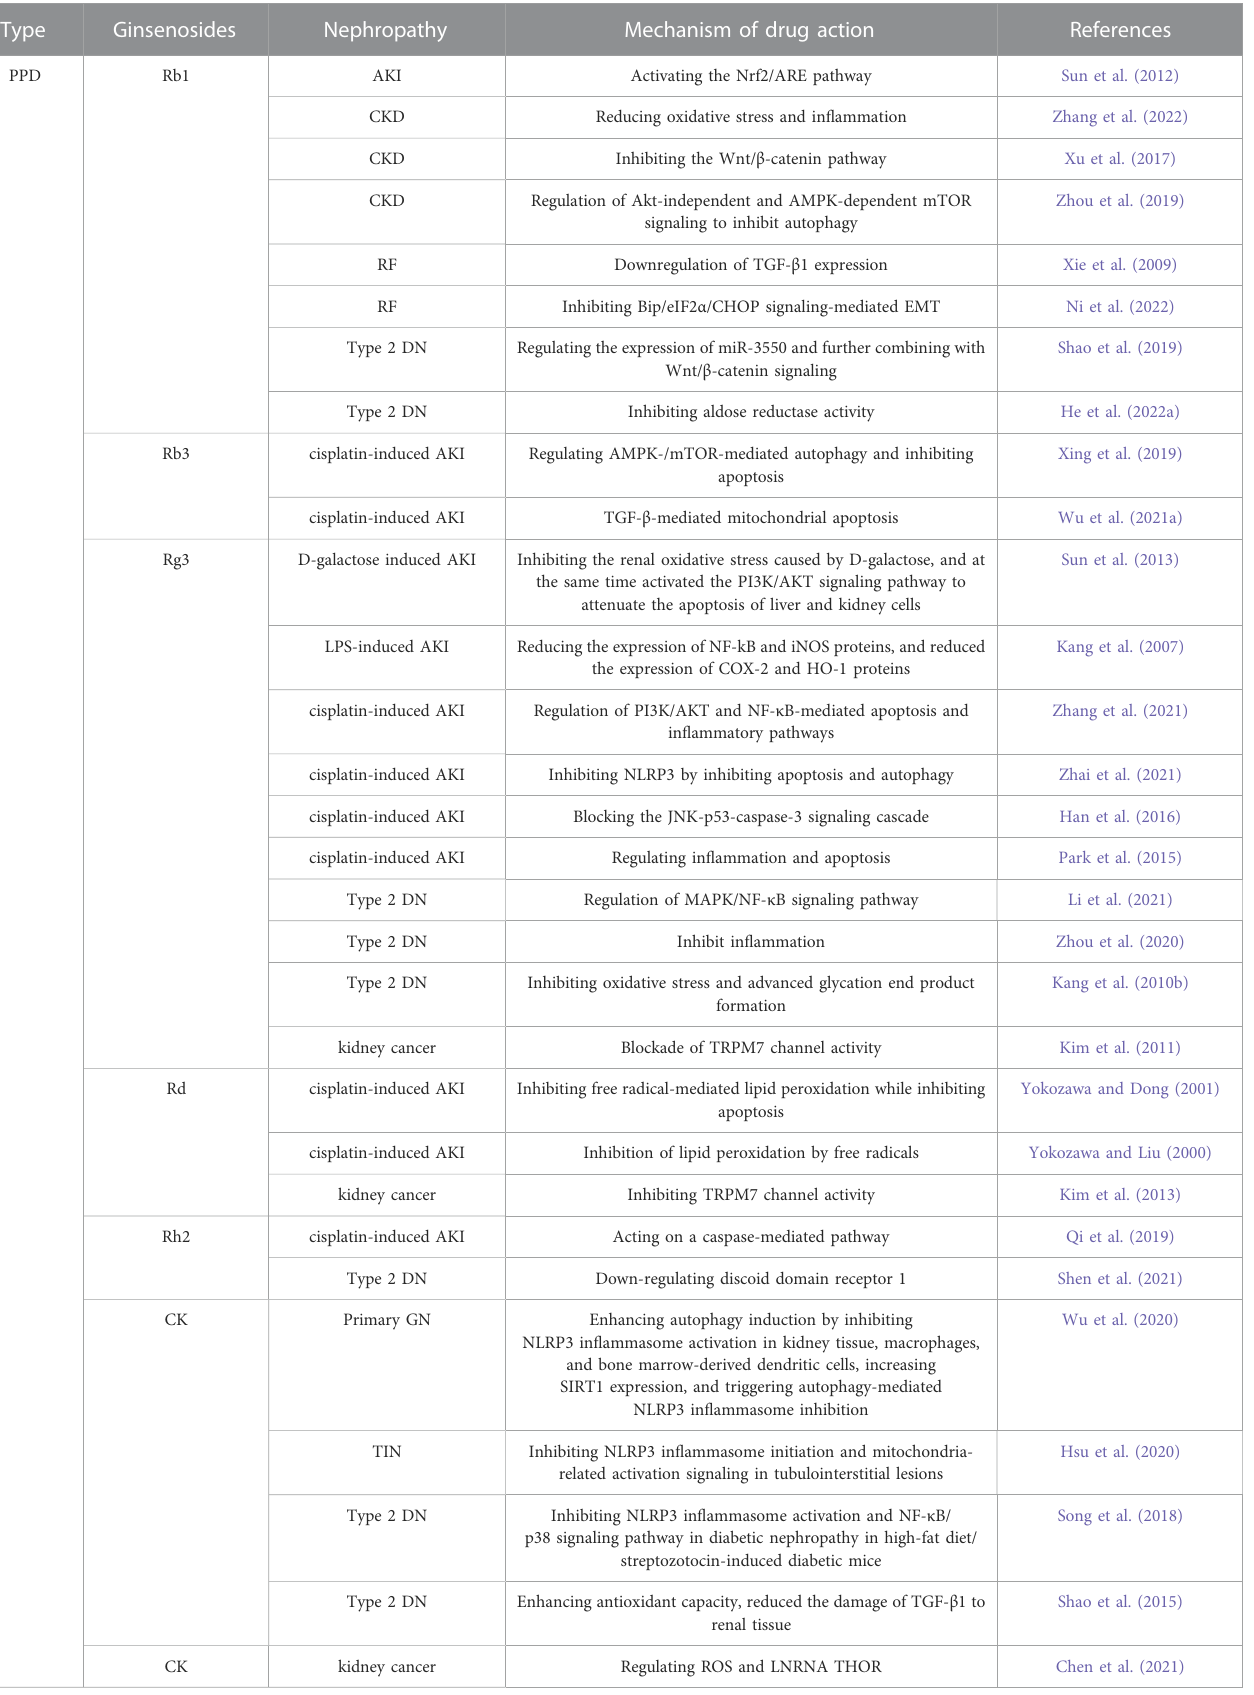
TABLE 1 The mechanism of action of various ginsenosides on different kidney related diseases.